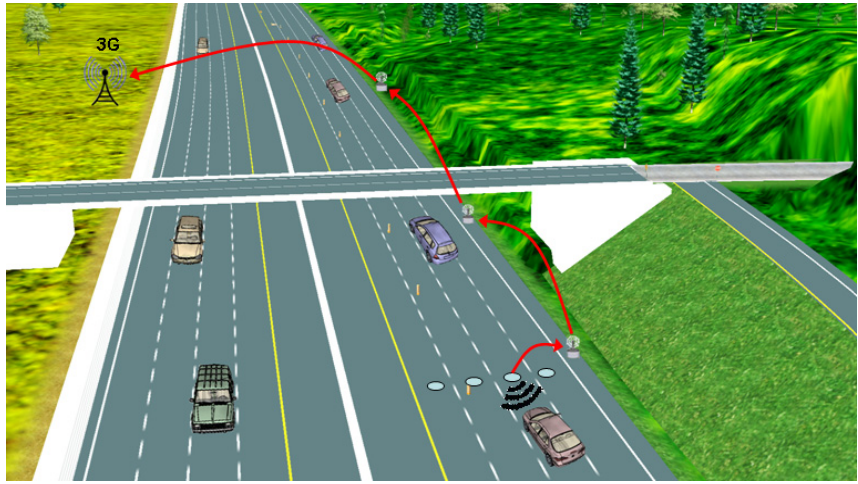
Figure 4. Distribution subsystem based on the availability of cellular